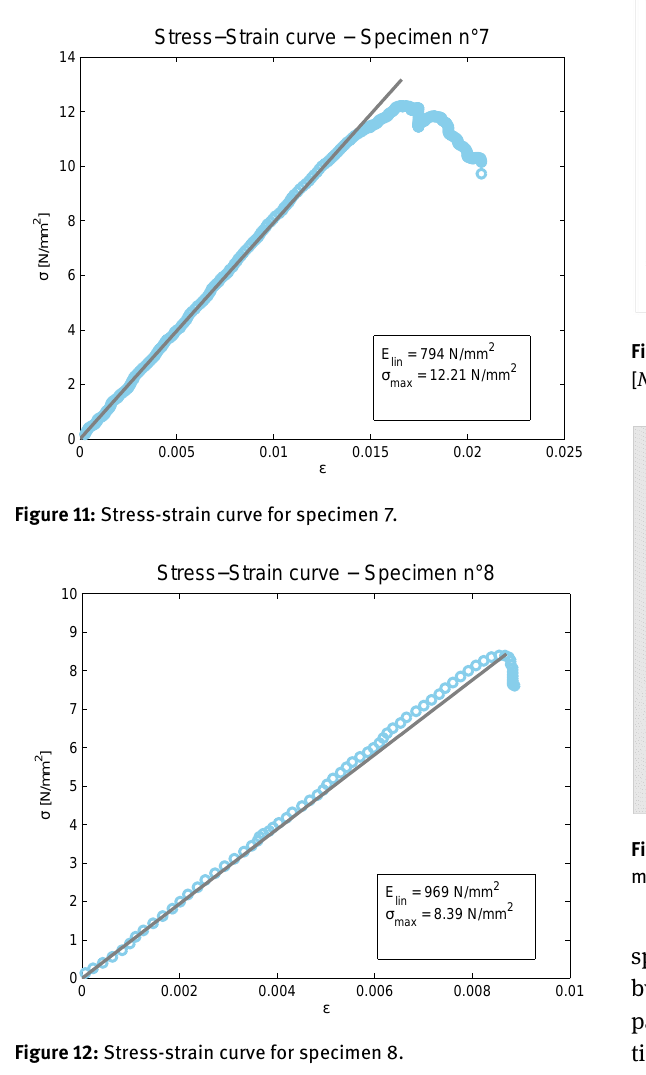
Figure 12: Stress-strain curve for specimen 8.